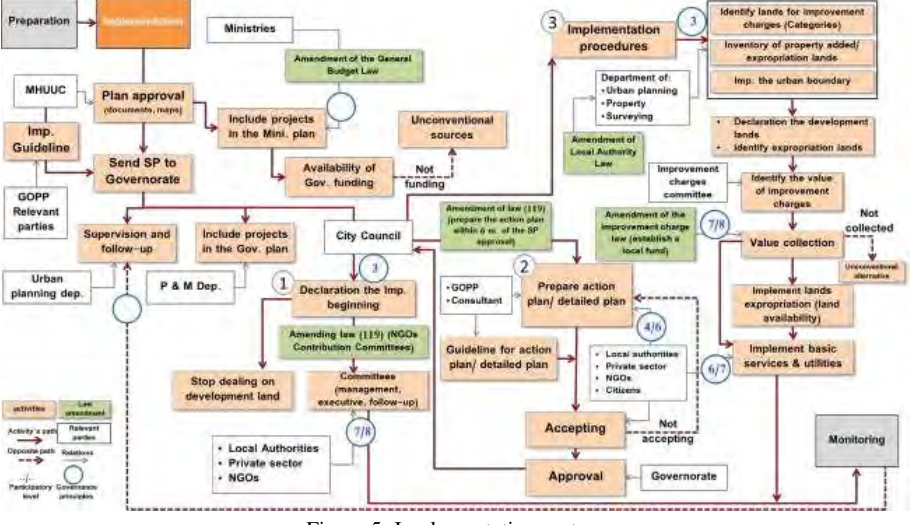
Figure 5. Implementation